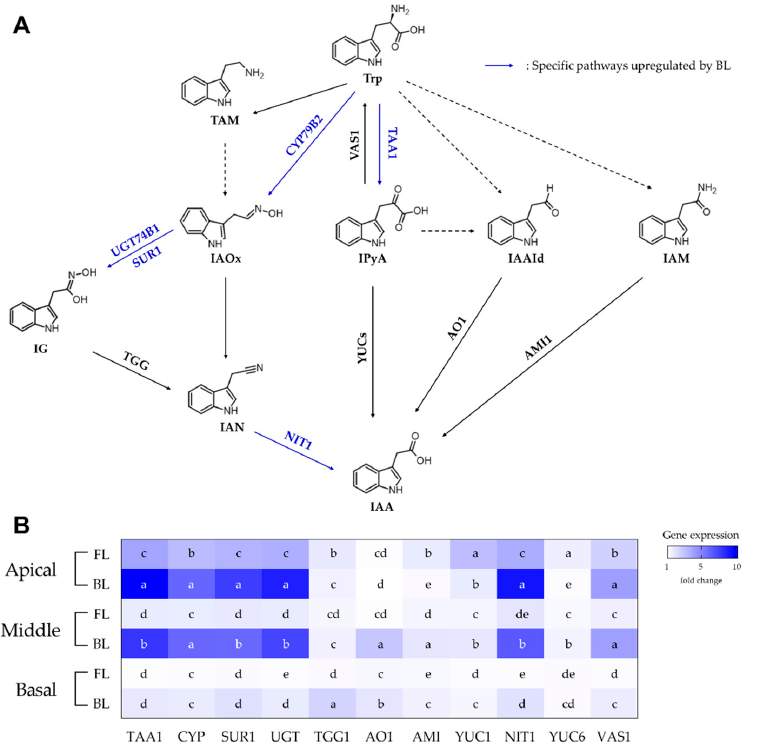
Figure 3. ( A ) Tryptophan (Trp)-dependent pathways for indole-3-acetic acid (IAA) biosynthesis in plants and ( B ) relative gene expression levels in apical, middle, and basal positions of rosemary cuttings treated with fluorescent lamp light (FL) or blue light (BL) for 7 days. Solid and dashed arrows indicate processes for which genes are known and unknown, respectively. Blue arrows indicate pathways specifically upregulated in BL-treated rosemary cuttings. Alphabets in heatmap mean statistical differences in gene expression among treatments within the same gene ( p < 0.05).